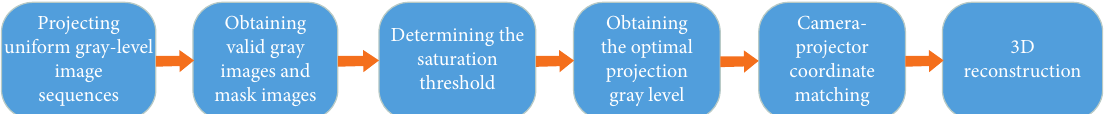
Figure 4: Flowchart of the adaptive digital fringe projection